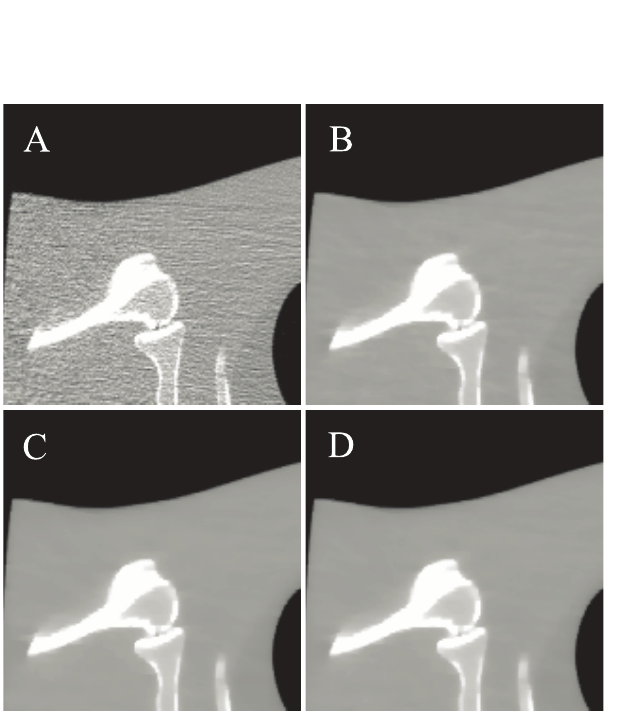
Fig 7. Zoomed details of the ROI in Fig 6. (A) FBP method; (B) NCG method; (C) SB-NCG method; and (D) ALM-ANAD